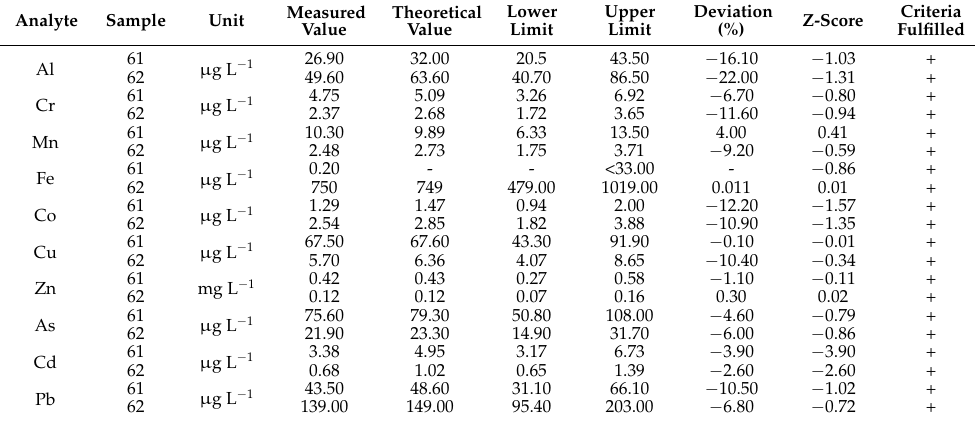
Table 8. Results of the external quality